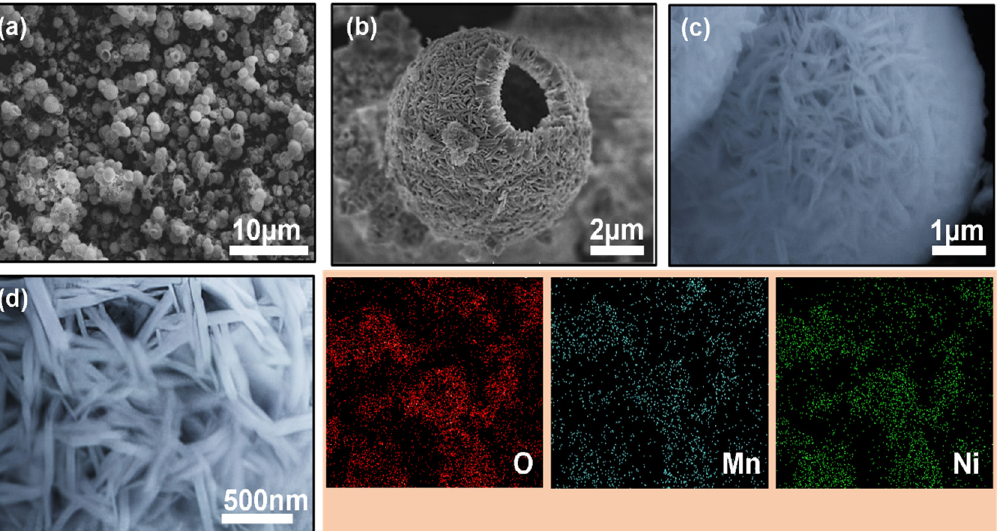
Figure 2. ( a – c ) HR-SEM images of NiMn-LDH-12 hollow sphere at different magnifications with corresponding ( d ) SEM-EDX image confirming the uniform distribution of O (oxygen), Mn (manganese), and Ni (nickel) elements.